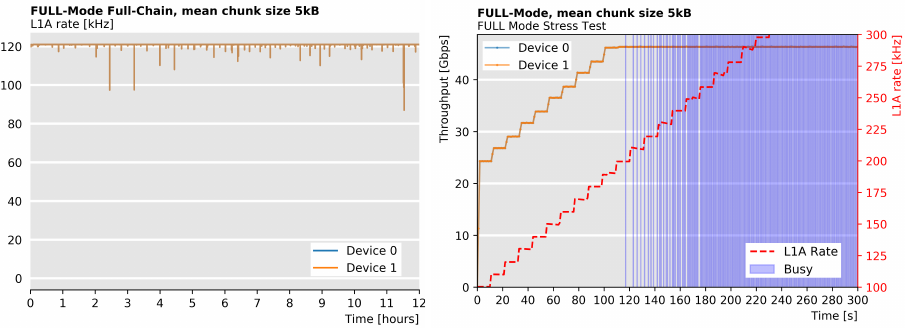
Figure 5. (left) Performance results for FULL mode, split by device (see Section 5) showing stable 120 kHz operation. (right) Stress test results for FULL mode, also split by device, where the L1 rate was increased until the FLX-712 asserted a signal known as XOFF, indicating saturation, indicated by the blue shaded region. In this case the combined throughout to the host across both devices was approximately 90 Gb /